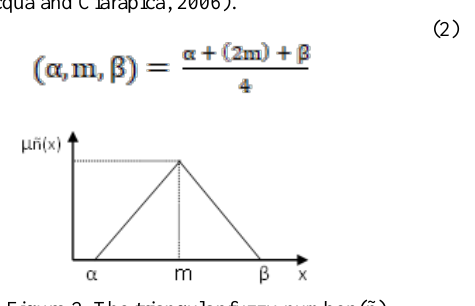
Figure 2 . The triangular fuzzy number (ñ)